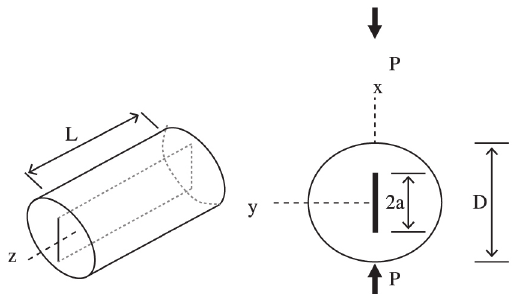
Figure 1. Geometry of the centrally cracked cylindrical